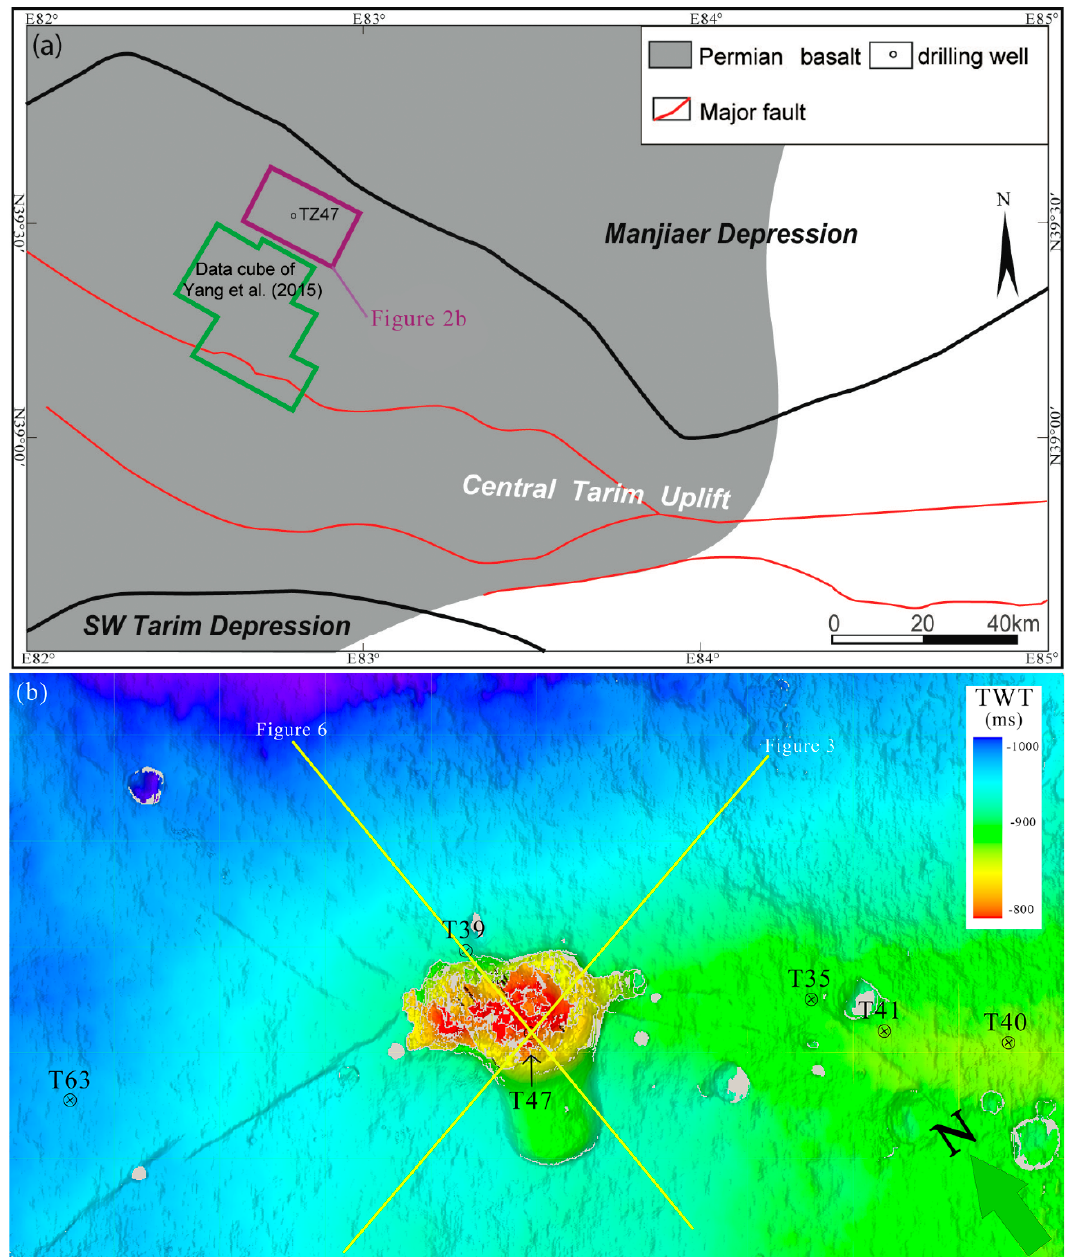
Figure 2. Maps of the study area. ( a ) Sketch geological map of the Central Tarim uplift showing the tectonic division, major faults and distribution of the Tarim flood basalt. Seismic cube in the study area is shown as purple rectangle in (a), which is to the northeast of the seismic cube studied in Yang et al. [31]; ( b ) color-visualized T0-isopleth showing the surface of the Permian basalt layer and the locations of the drilling wells in the study area. Thick yellow lines in (b) represent the location of two seismic profiles in Figures 3 and 6. TWT: two-way time.